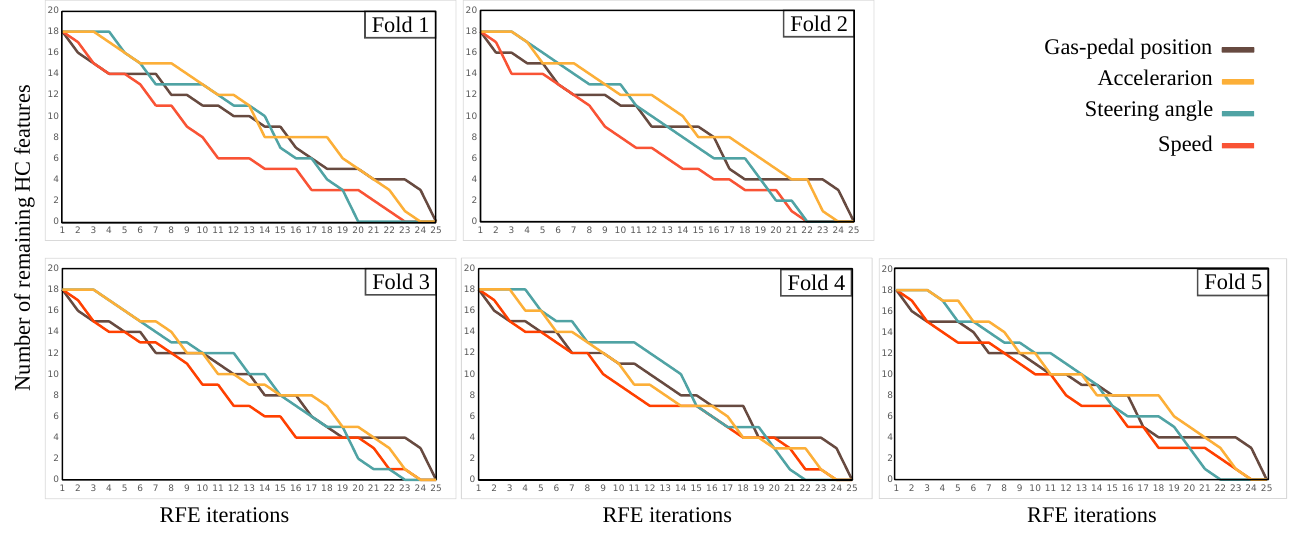
Figure 7. RFE results per sensor channel for five cross-validation folds. The y-axis shows the number of remaining features from each sensor, and the x-axis shows the step by step removal of features from each